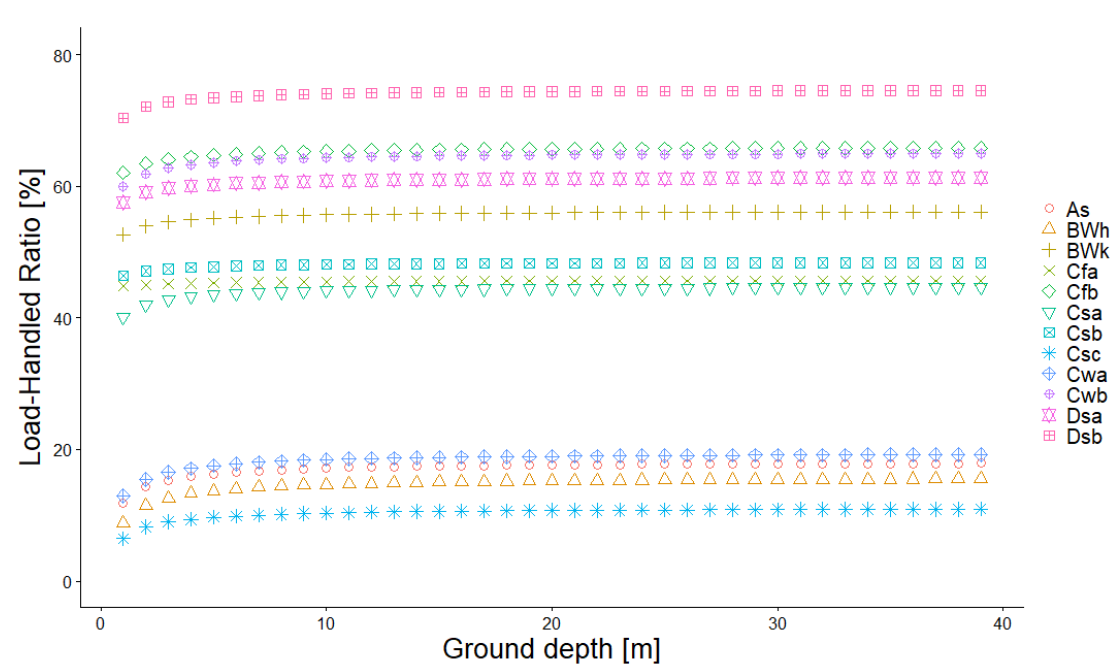
Figure 12. LHR of TABS depending on ground depth.